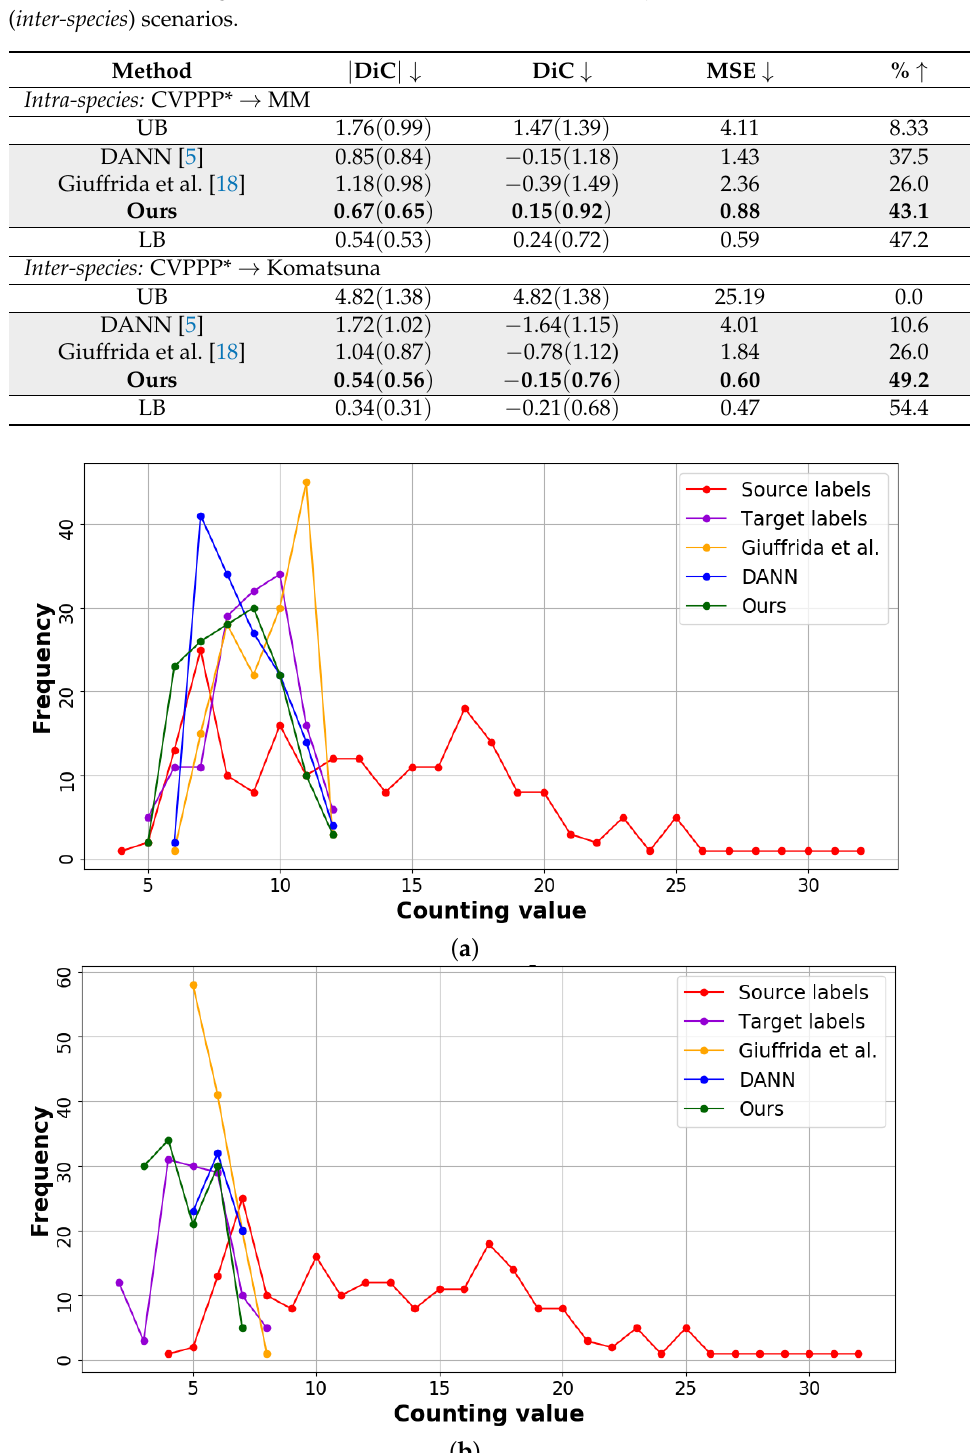
Figure 5. Visual representation of the leaf counting results. ( a ) Intra-species: CVPPP* [43,44] → MM [45]. ( b ) Inter-species: CVPPP* [43,44] → Komatsuna